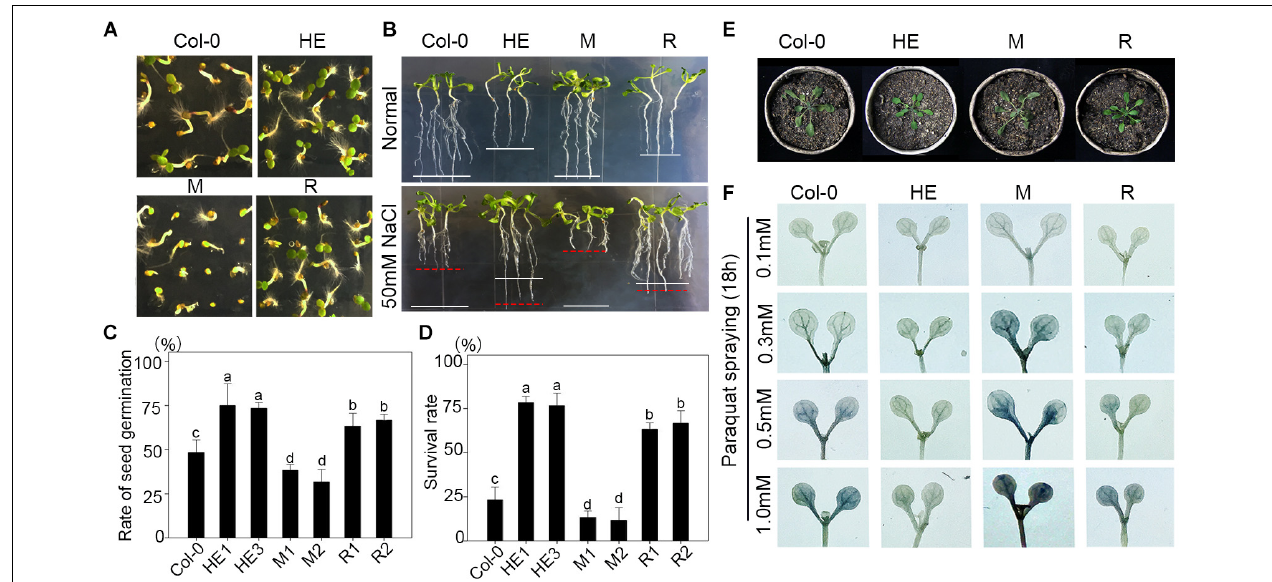
FIGURE 2 | Overexpressed EsNAC1 improved the salt and oxidative stress resistance of Arabidopsis . (A) Phenotypes of seedlings from Col-0 and HE, M and R lines after germinating on 1/2 MS-agar with 100 mM NaCl for 3 days. (B) Phenotypes of plants from Col-0 and HE, M and R lines after germinating on 1/2 MS-agar for 10 days or 50 mM NaCl for 15 days. White lines denote the average length of plants under the normal condition; red lines denote the average length of plants under salt stress. (C) The statistical results for rate of seed germination on 1/2 MS-agar with 100 mM NaCl after sowing for 5 days. (D) The statistical results of the survival rate of 4-week-old plants after 200 mM NaCl treatment for 7 days. (E) Phenotypes of 4-week-old plants from Col-0 and HE, M and R lines after watering was stopped for 5 days. (F) The NBT staining results after treatment with different concentrations of paraquat for 18 h. Values represent the mean ± SD, and those labeled with a letter are significantly different at P < 0.05 by Duncan’s test. Three biological replicates were in the experiment, with each biological replicate with four dishes or 16